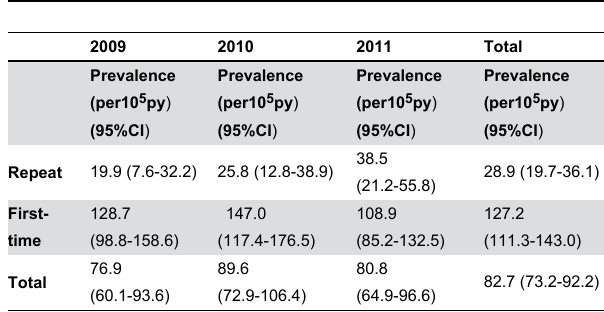
Table 3. HBsAg prevalence among blood donations in Anhui from 2009 to 2011.